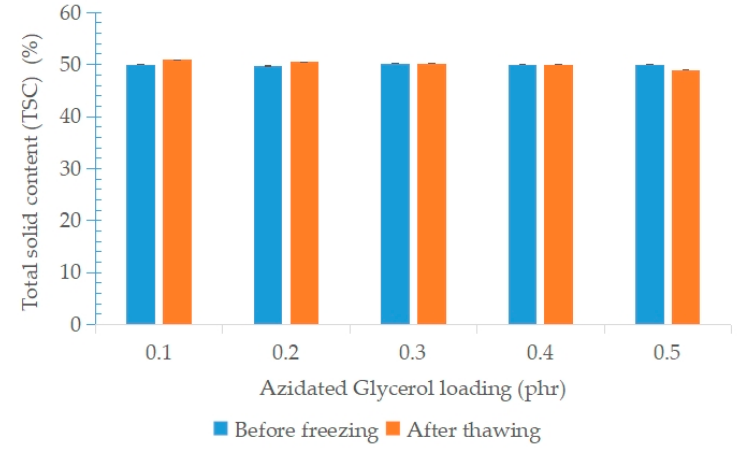
Figure 11. Total solid content of NRL containing variable loadings of AG before freezing and after the freeze–thaw processes.